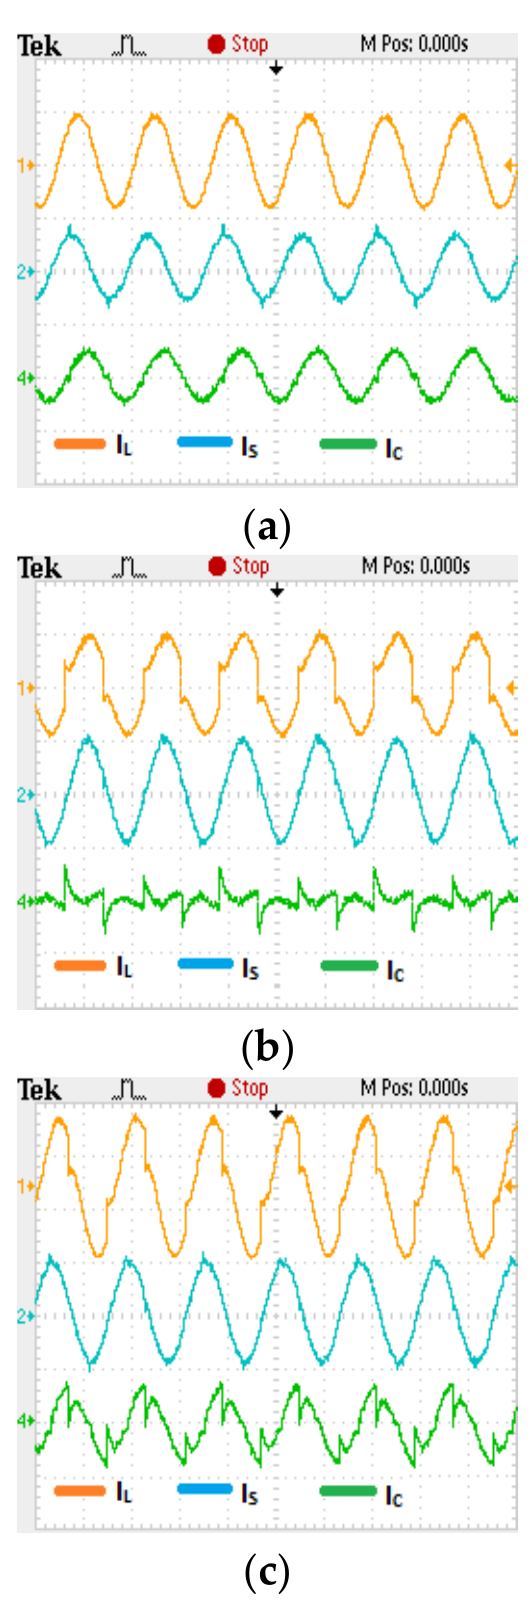
Figure 15. OPAL-RT results of load current (I L ), source current (I S ) and compensating current (I C ) Figure 15. OPAL ‐ RT results of load current (I for different load conditions: ( a ) linear load only; ( b ) non-linear load only; ( c ) composite load (both for different load conditions: ( a ) linear load only; ( b ) non ‐ linear load only; ( c ) composite load (both linear and linear and non ‐ linear).